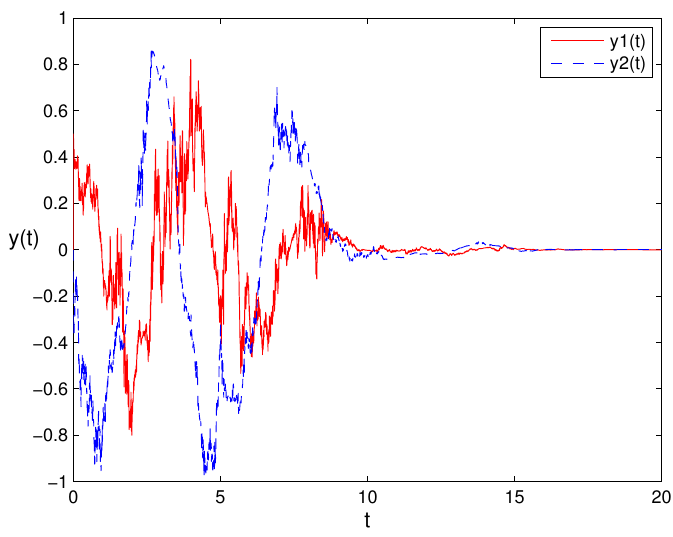
Figure 3. The trajectory of y ( t ) in system